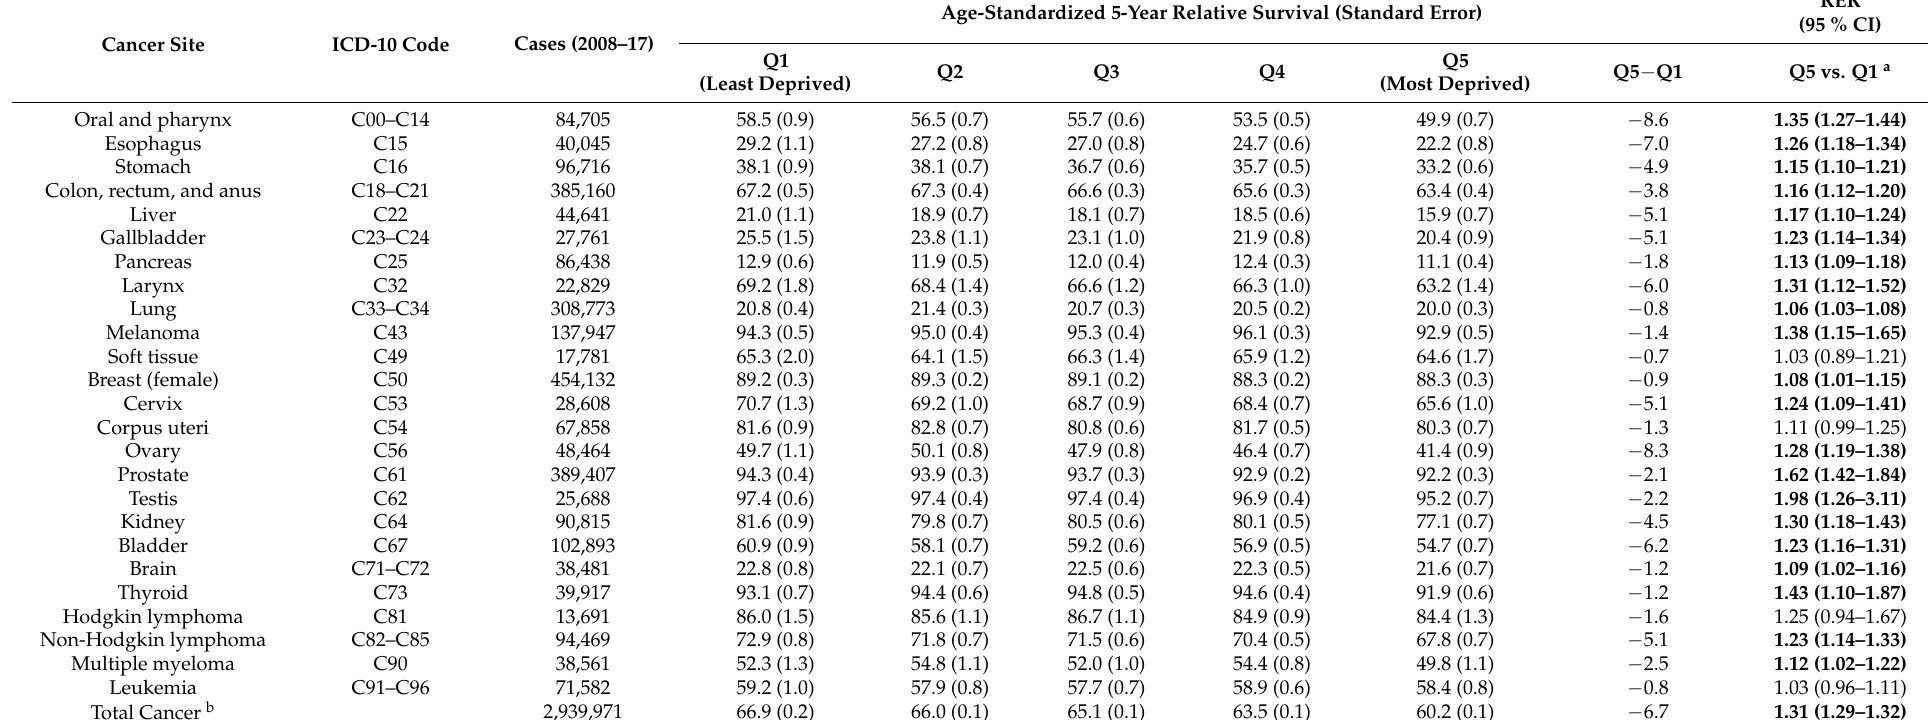
Table 2. Age-standardized five-year relative survival in 2013–2017 by cancer site and deprivation quintile in the study